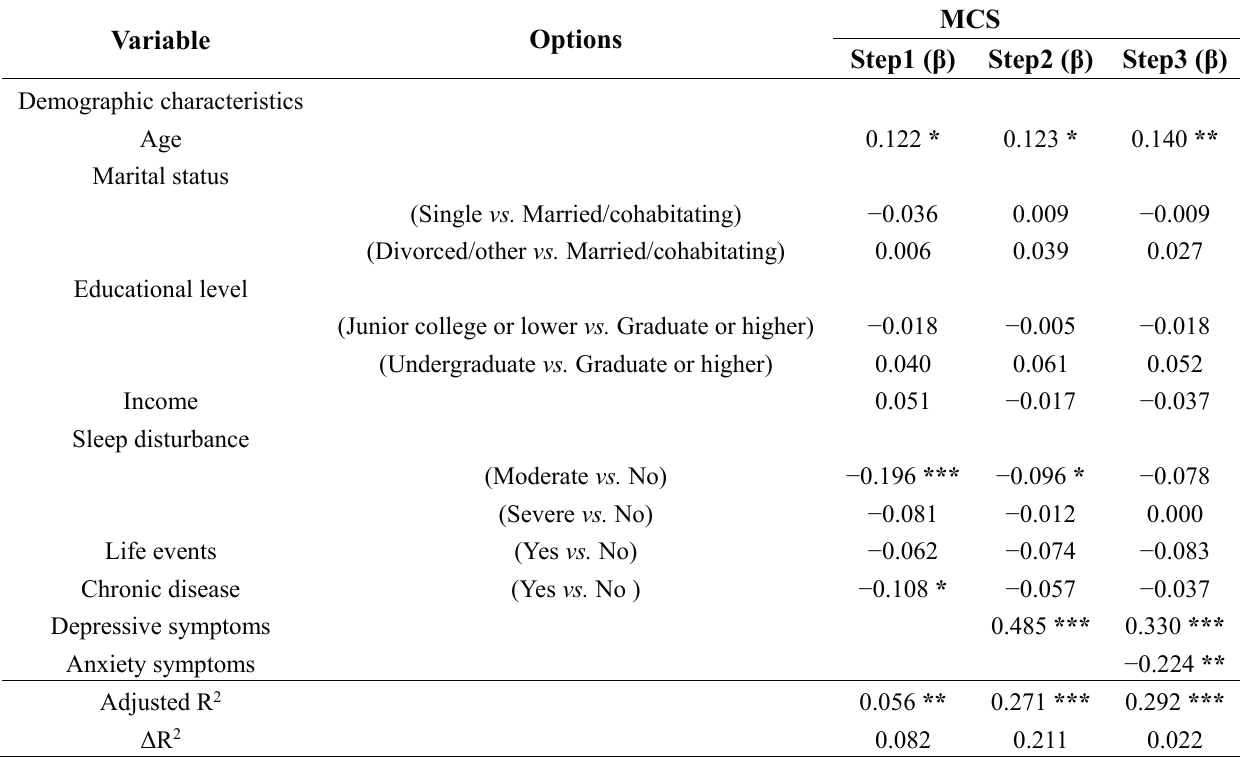
Table 4. Hierarchical multiple regression predicting MCS